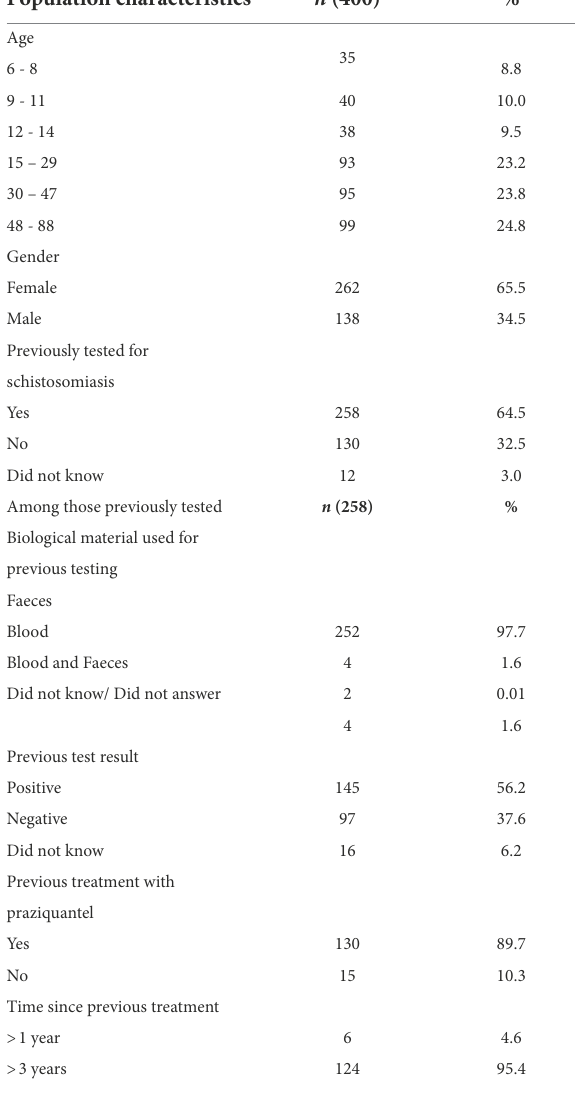
TABLE 2 Summary of the demographic data of the study population ( N = 400). Population